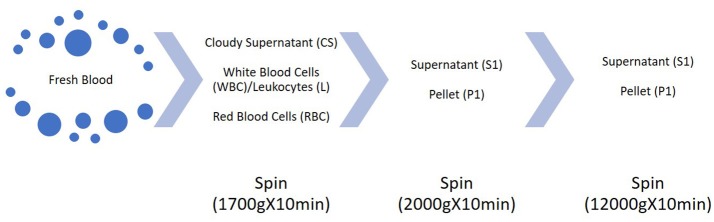
Scheme of the multiple centrifugation steps performed in Duttagupta et al. (2011).